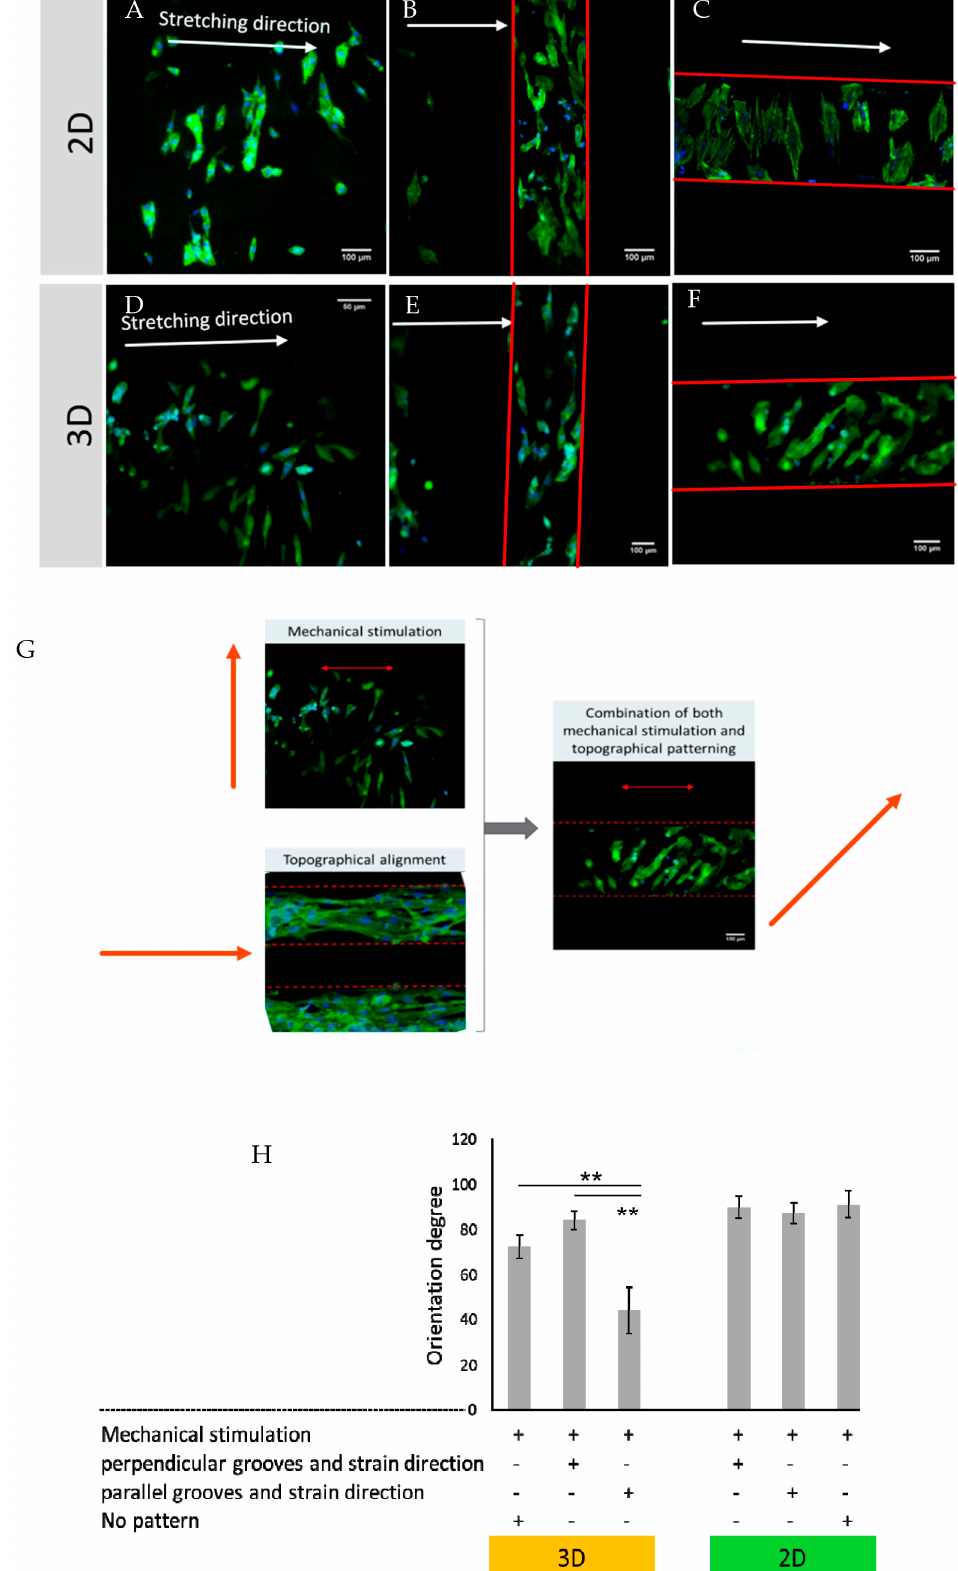
Figure 5. H9c2 co-cultured cells in 350 µ m width and height grooves, stained with Phalloidin and DAPI, with cell concentration of 1 million cells/mL, stimulated under: ( A ) 2D culture without pat- tern; (B) 2D culture with pattern perpendicular to the direction of stimulation; (C) 2D culture with